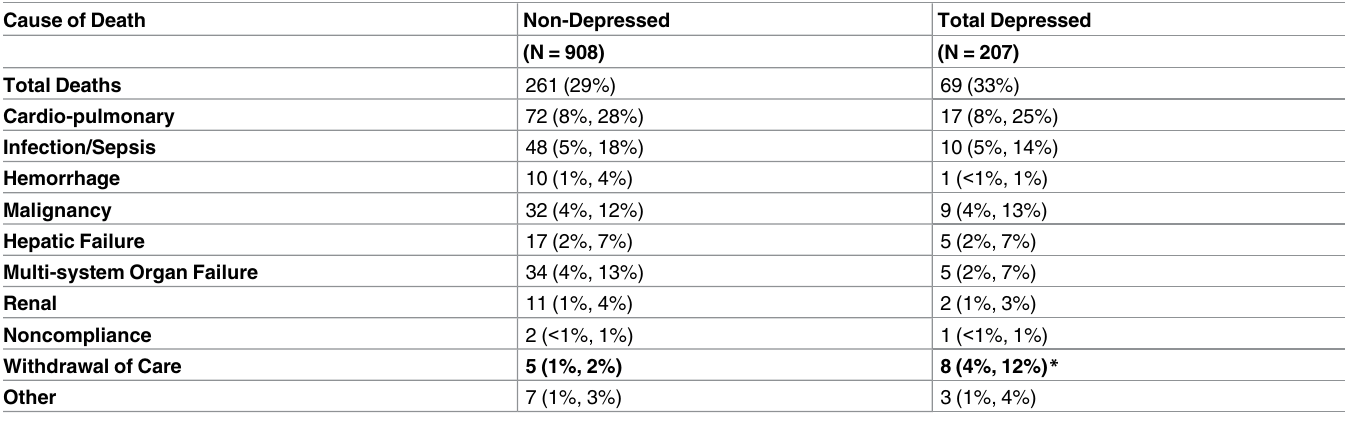
Table 4. Causes of Death by Depression Status (n =